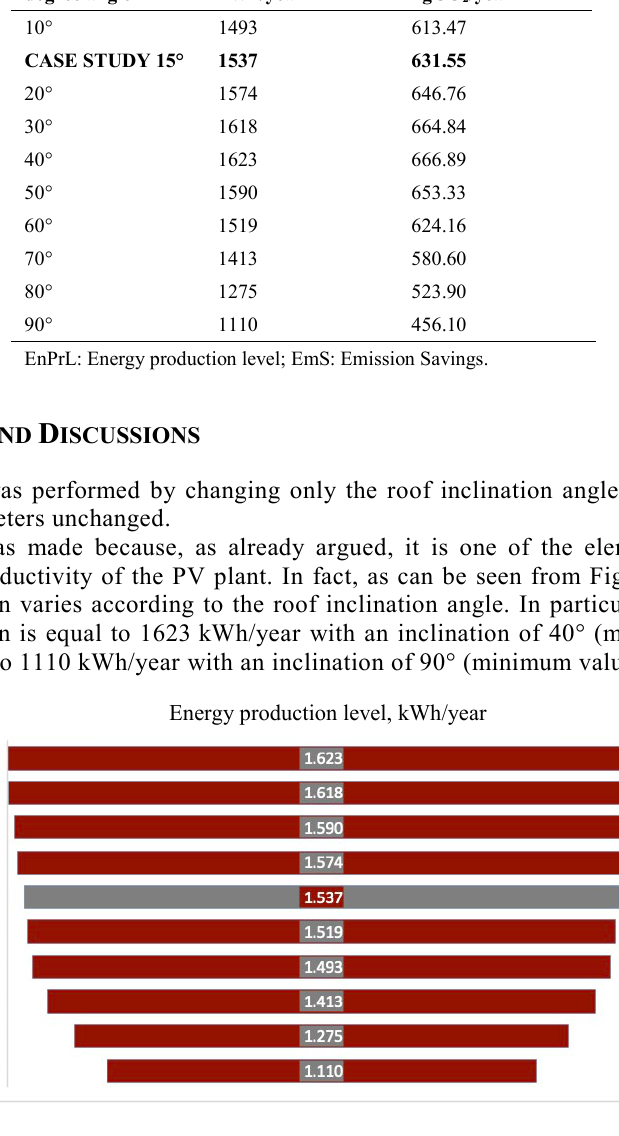
Fig. 4. Energy production level in kWh/year at different roof tilt. The value obtained when the angle is equal to 15° (case study) are pointed out in grey. The LCCA values also vary according to the roof inclination angle (Fig.